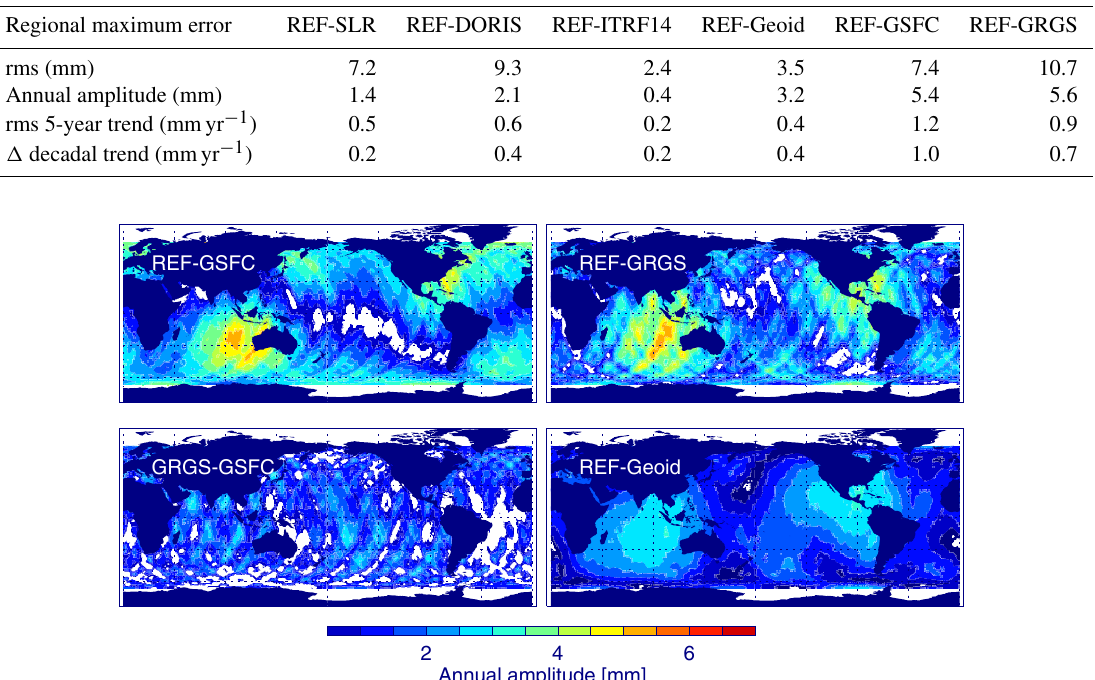
Table 5. Estimates of regional maximum orbit-related errors for the total and seasonal signals, and interannual and decadal trends. Values are derived from the radial orbit differences for REF minus SLR, REF minus DORIS, REF minus ITRF14, REF minus Geoid, REF minus GSFC, and REF minus GRGS for the period April 1993–June 2004. Details on the estimation method are given in Sect. 3.1.